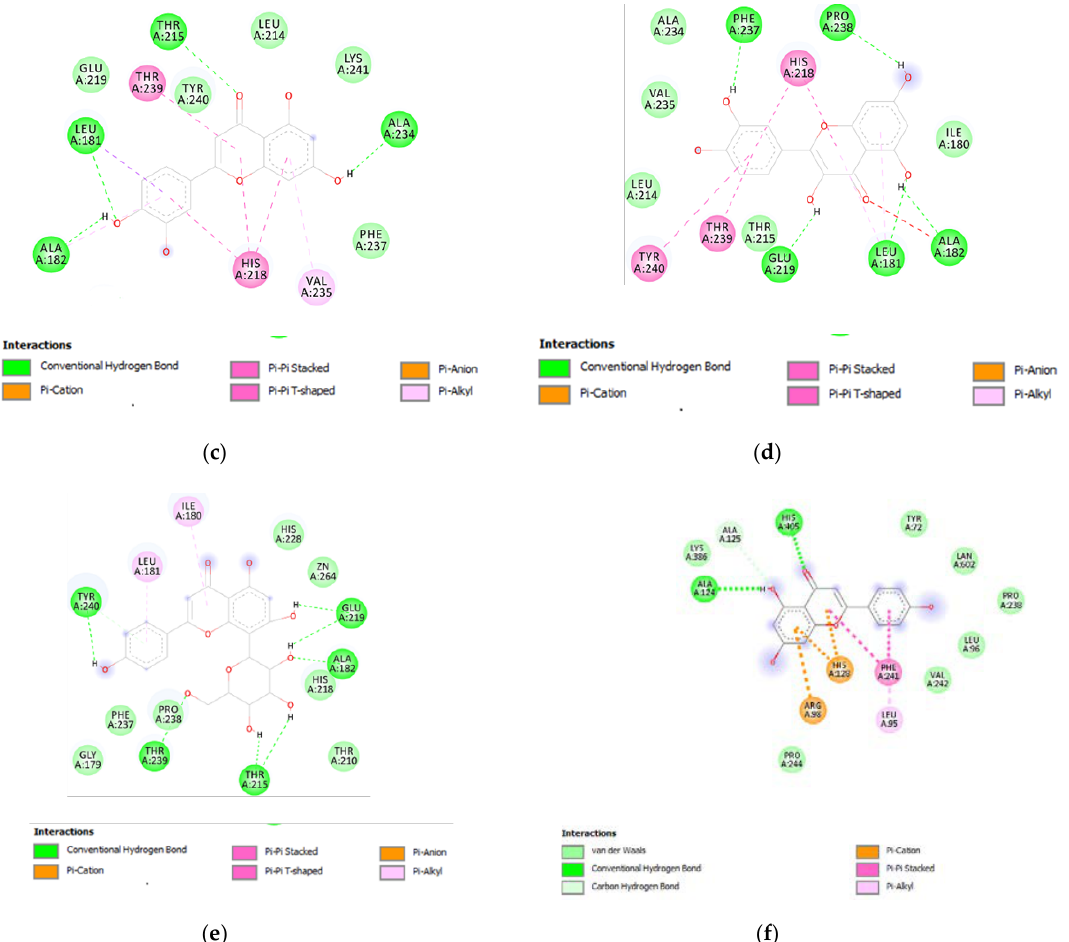
Figure 8. ( a ) Putative interactions between apigenin and MMP-12 (PDB: 3F17). Free energy of binding ( ∆ G) and a ffi nity (Ki) are − 8.3 kcal / mol and 0.8 µ M, respectively. ( b ) Putative interactions between isovitexin and MMP-12 (PDB: 3F17). Free energy of binding ( ∆ G) and a ffi nity (Ki) are − 8.8 kcal / mol and 0.4 µ M, respectively. ( c ) Putative interactions between luteolin and MMP-12 (PDB: 3F17). Free energy of binding ( ∆ G) and a ffi nity (Ki) are − 8.7 kcal / mol and 0.4 µ M, respectively. ( d ) Putative interactions between quercetin and MMP-12 (PDB: 3F17). Free energy of binding ( ∆ G) and a ffi nity (Ki) are − 8.7 kcal / mol and 0.4 µ M, respectively. ( e ) Putative interactions between vitexin and MMP-12 (PDB: 3F17). Free energy of binding ( ∆ G) and a ffi nity (Ki) are − 8.8 kcal / mol and 0.3 µ M, respectively. ( f ) Putative interactions between apigenin and lanosterol-14-alpha demethylase (PDB: 4LXJ). Free energy of binding ( ∆ G) and a ffi nity (Ki) are − 8.8 kcal / mol and 0.4 µ M, respectively.